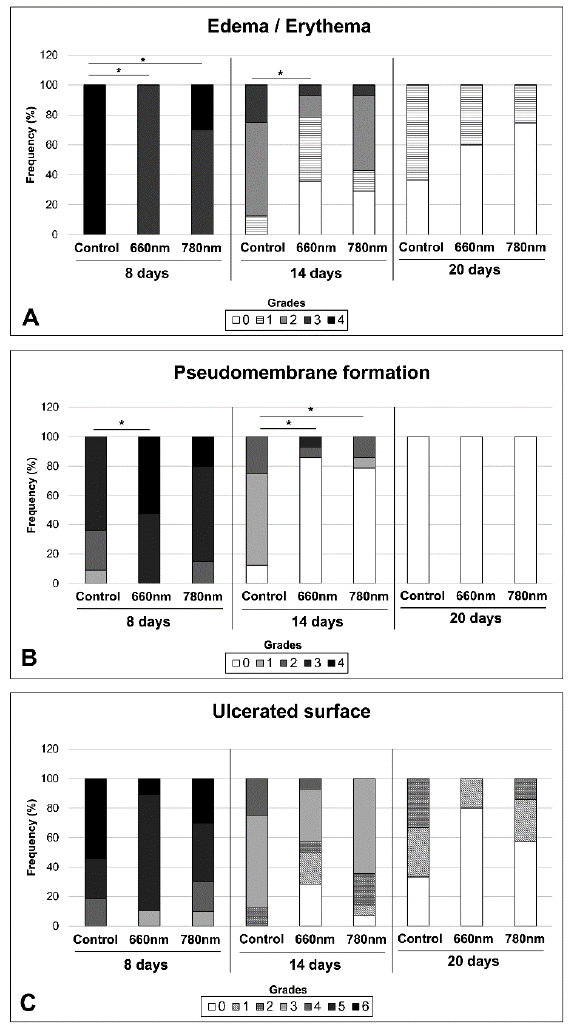
Figure 3. Frequency of severity grades for edema/erythema ( A ), pseudomembrane formation ( B ) and ulcerated surface ( C ) attributed to oral mucositis induced with ionizing radiation (control group) and treated with photobiomodulation performed with λ = 660 nm (660 nm group) and λ = 780 nm (780 nm group). The tongue was analyzed after 8, 14, and 20 days of ionizing radiation. The grade description for each clinical variable is shown in Table 1. * p < 0.05 (Kruskal–Wallis test, followed by Tukey´s test).